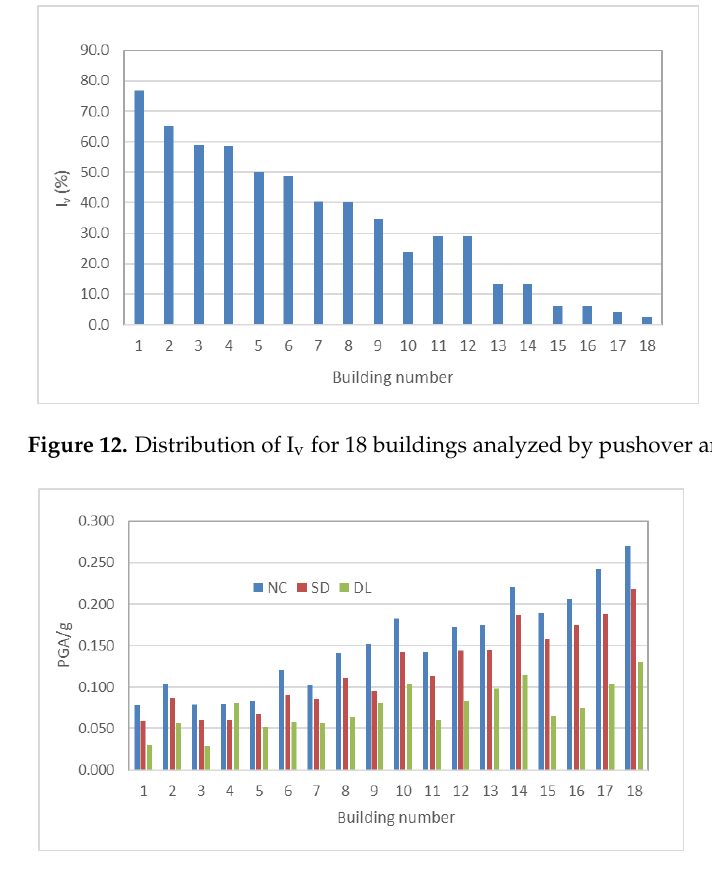
Figure 13. Peak ground accelerations for NC, SD, and DL limit states calculated by pushover anal- ysis.